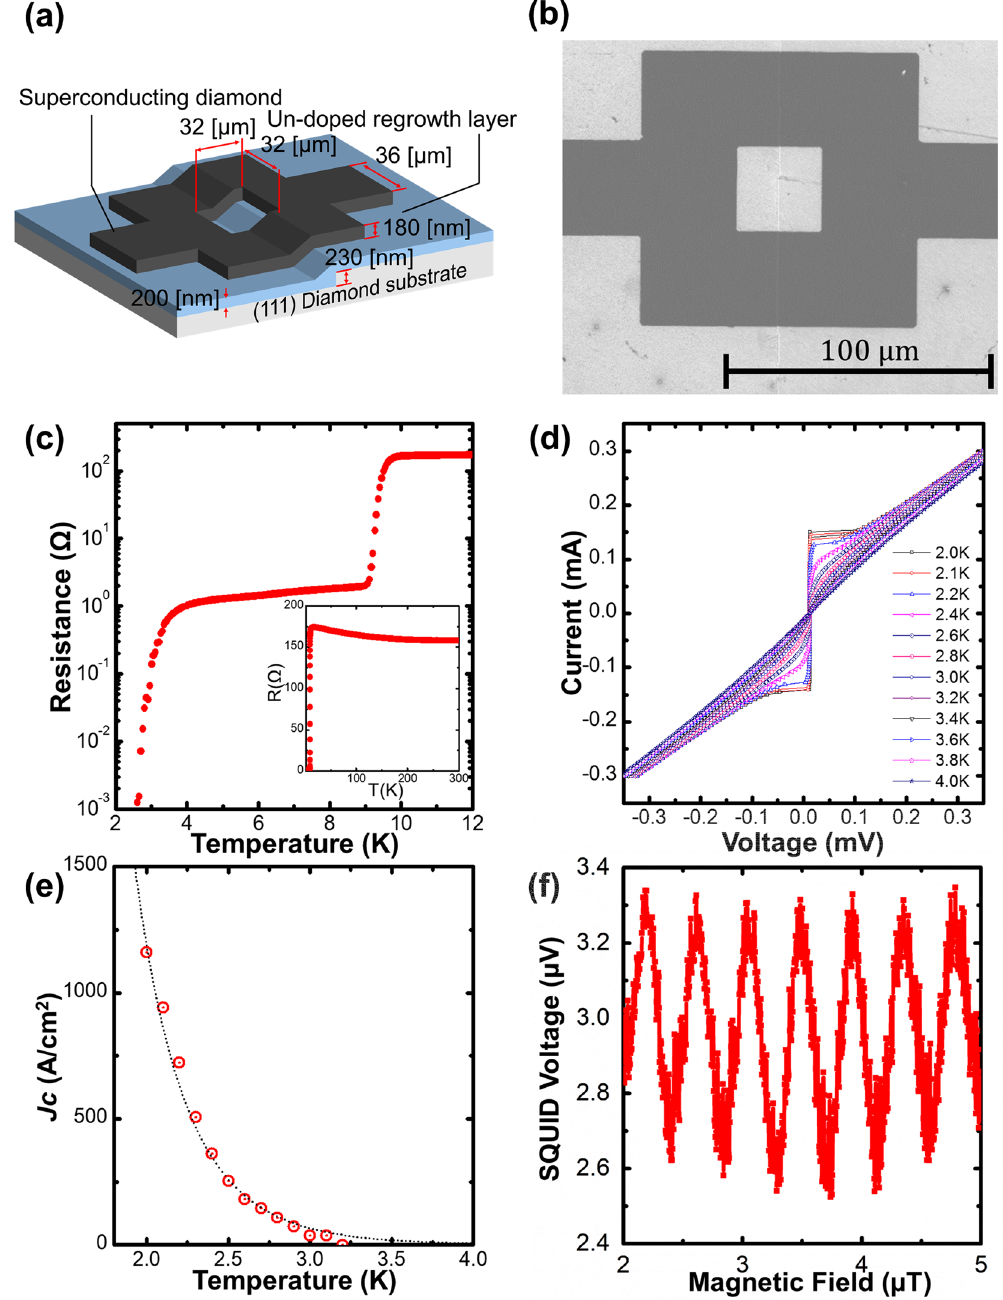
Figure 4. ( a ) Schematic diagram of the fabricated diamond SQUID. ( b ) Overview SEM image of fabricated SQUID. ( c ) Temperature dependence of the resistance. The inset shows the measurements from 300 K to 2 K. ( d ) I – V characteristics from 2.0 K to 4.0 K. ( e ) Temperature dependence of the critical current density. ( f ) Flux– voltage ( Φ − V ) characteristics of the fabricated SQUID at 2.6